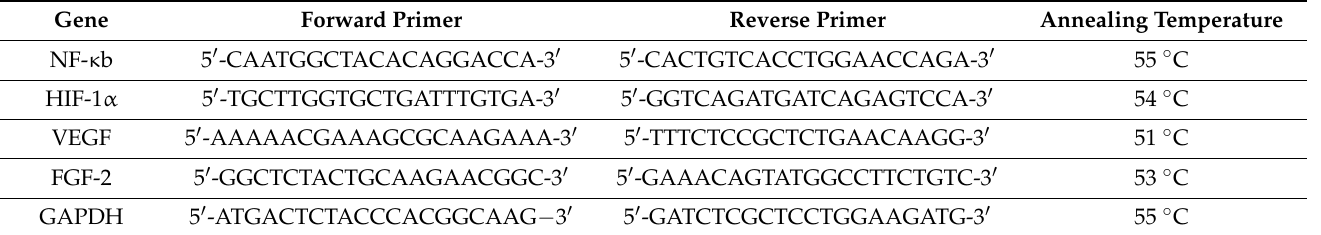
Table 1. Primer sequences and annealing temperatures for the measured